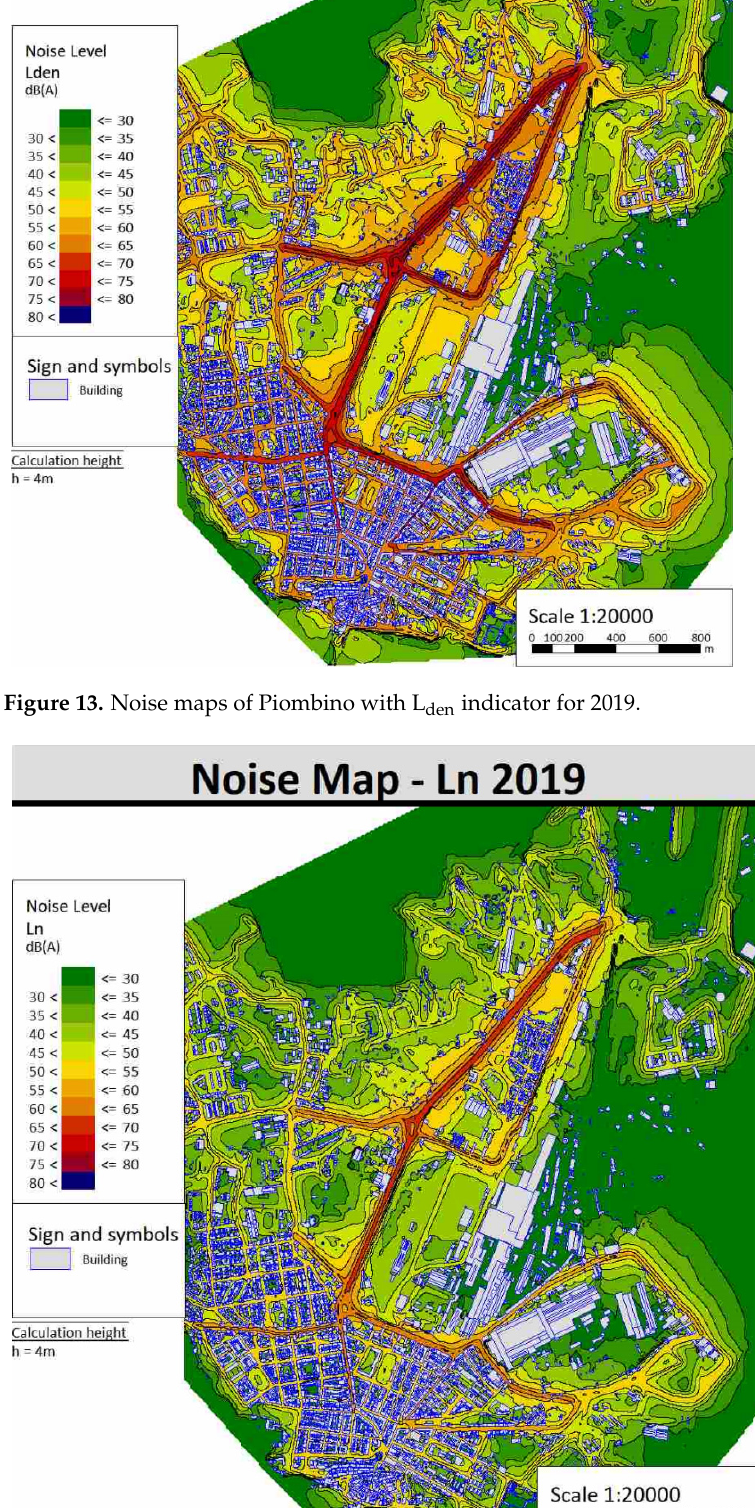
n indicator for